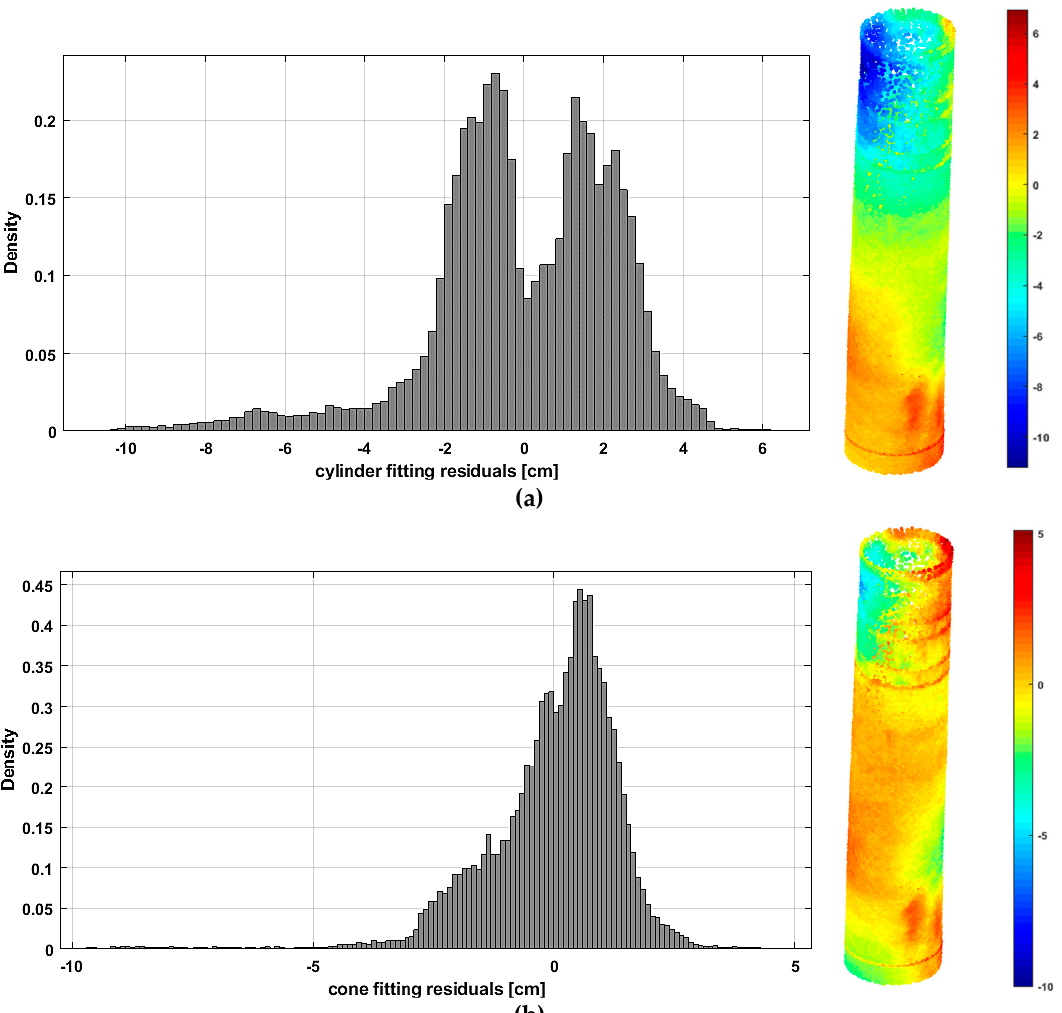
Figure 11. Cylindrical and conical geometric primitive fitting results. ( a ) The distance between the point cloud and the best fit cylinder surface ( σ = ± 2.3 cm). ( b ) The distance between the point cloud and the best fit conic surface ( σ = ± 1.4 cm).